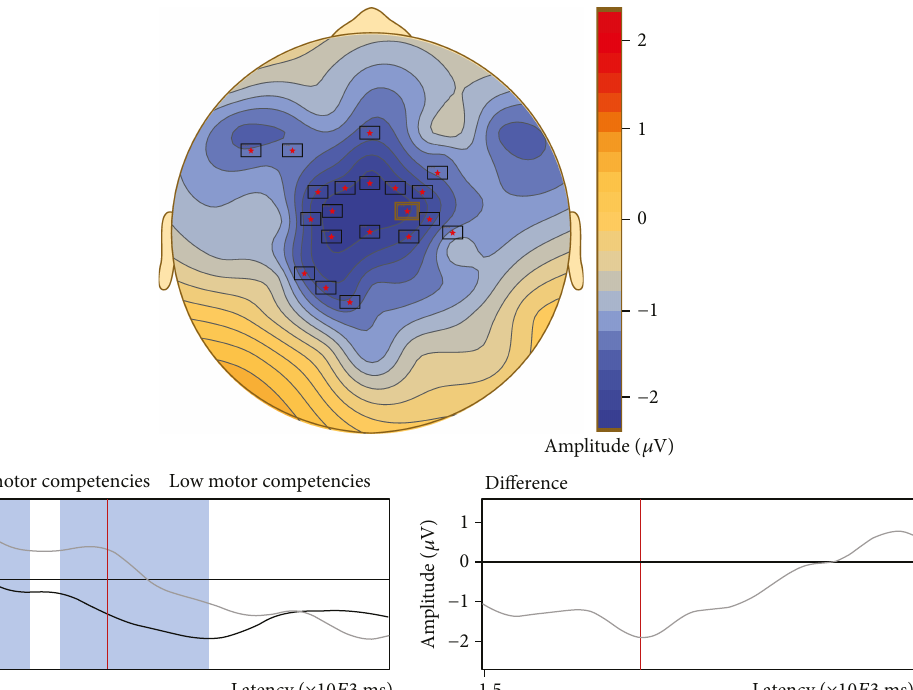
Figure 2: Comparison of the iCNV component ( − 1500 to − 1000 ms) of event-related potentials between adolescents with low and high motor competencies using cluster-based permutation testing. Note: stars indicate a cluster showing signi fi cant di ff erences between groups in a given latency range; negative values denote greater negative amplitudes in adolescent with low motor competencies compared to those with high motor